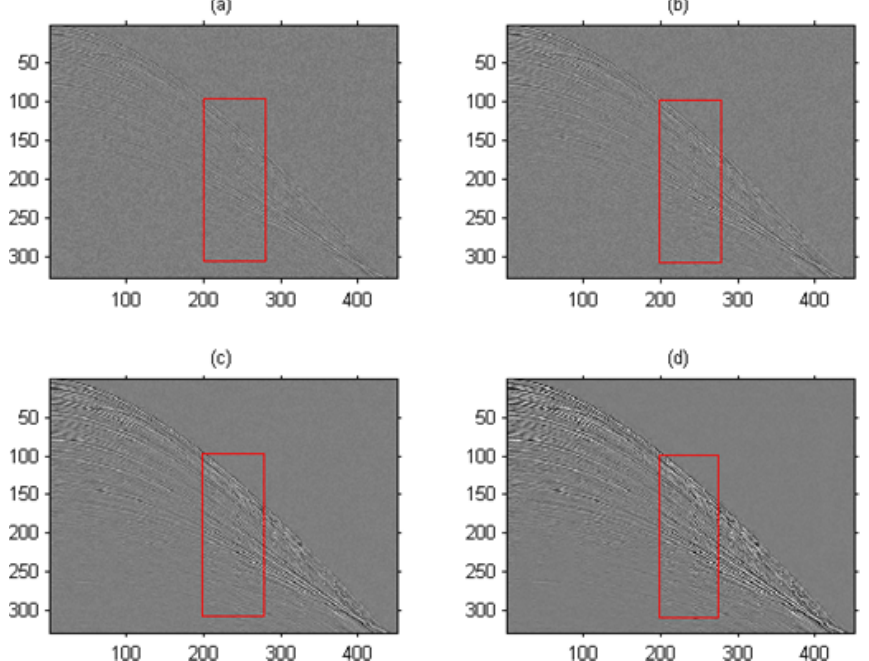
Figure 7. The results of our algorithm and comparison algorithm (The red box shows rock type characteristics of the depositional sequence in the seismic event). (a) Original seismic section images; (b) wavelet enhancement algorithm; (c) bilateral filtering enhancement algorithm; (d) our